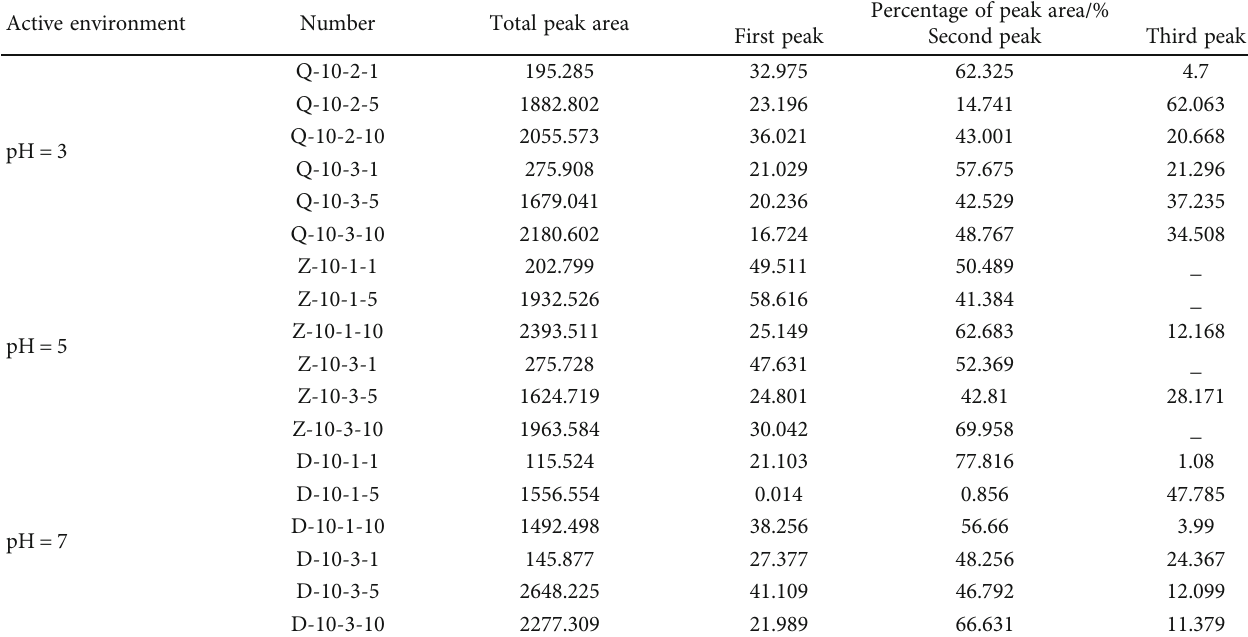
Table 3: T spectrum area under di ff erent operating environments and di ff erent numbers of dry-wet cycles. 2 Active